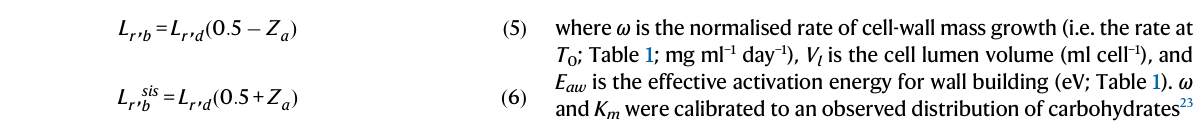
Effective activation energy for wall building